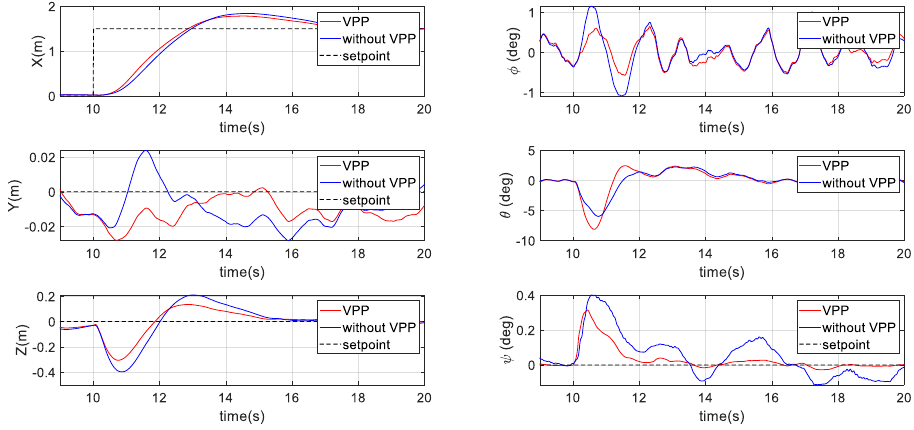
Figure 8. Results of the second scenario with a step command in the simulation.